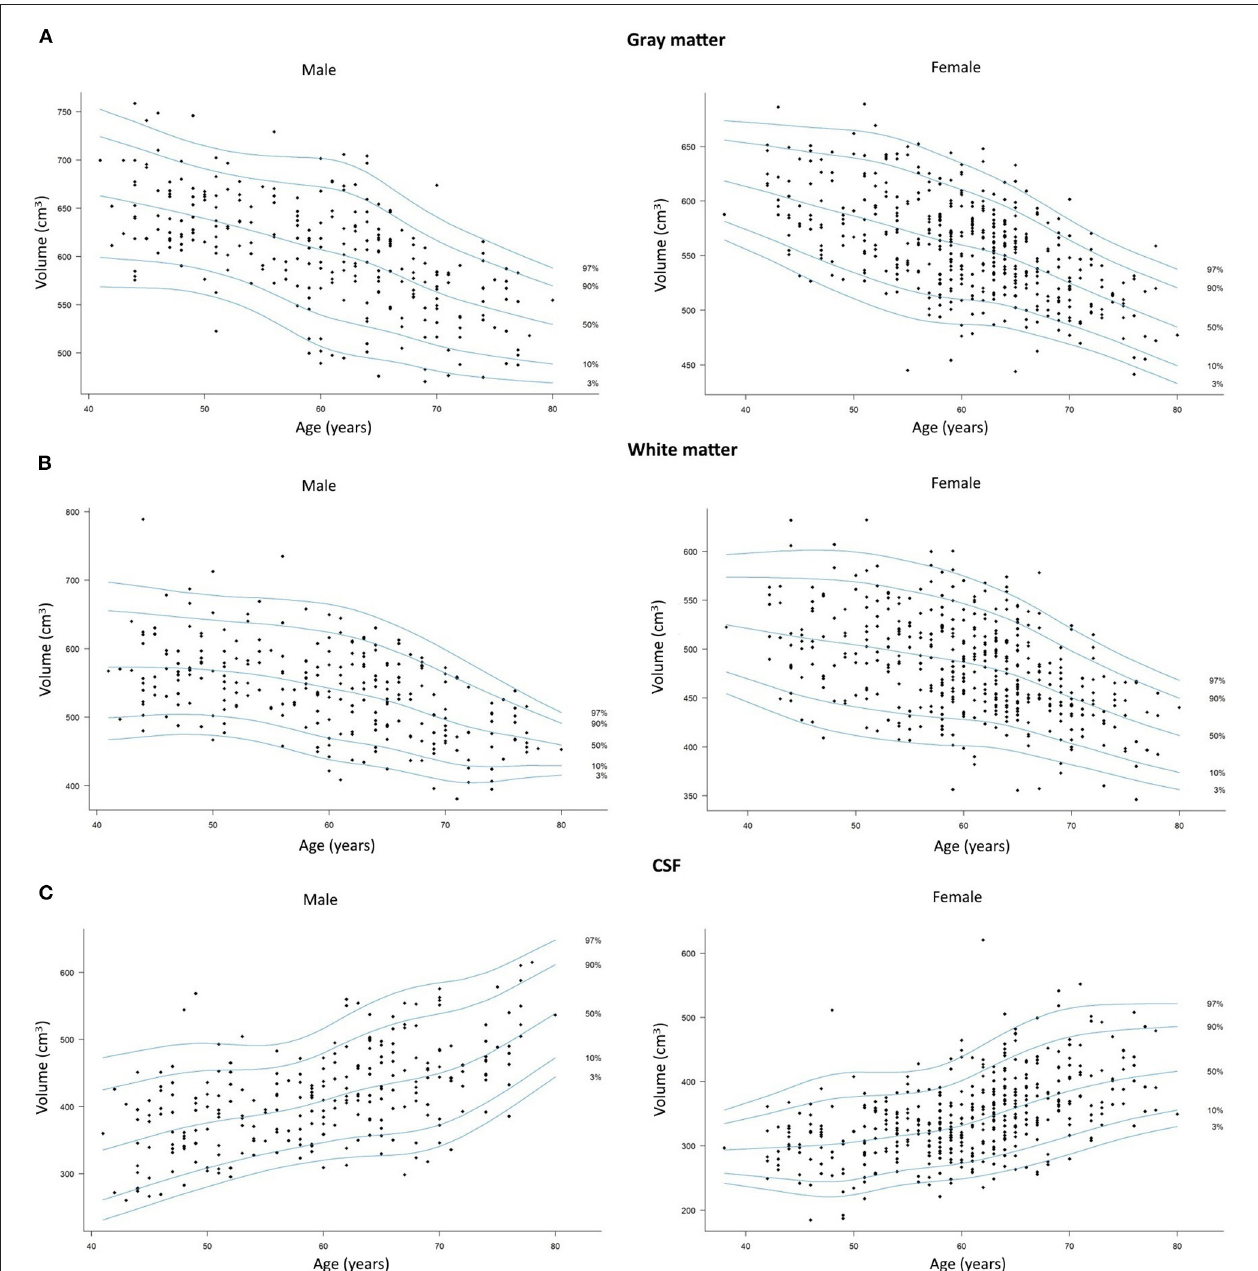
FIGURE 2 | Scatterplots with percentile curves of the (A) total gray matter, (B) total white matter, and (C) cerebrospinal fluid volumes in men and women. Dots represent single subjects.